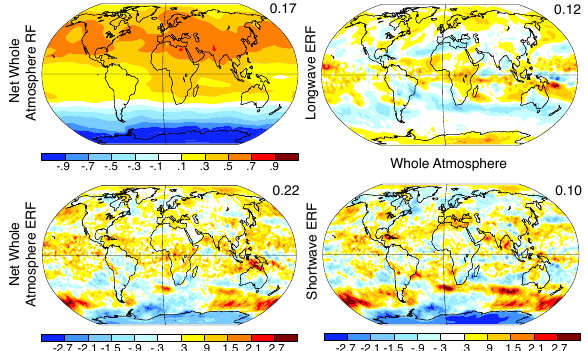
Fig. 16. Zonal mean ozone radiative forcing (Wm − 2 ) for the indi- cated time periods relative to the 1850–1875 mean. Forcing val- ues for 1951–1975 and earlier 25 yr periods are the transient iRF · RF 1970 /iRF 1970 , while the values at 1970 and 2005 are from the offline RF radiative transfer calculations.